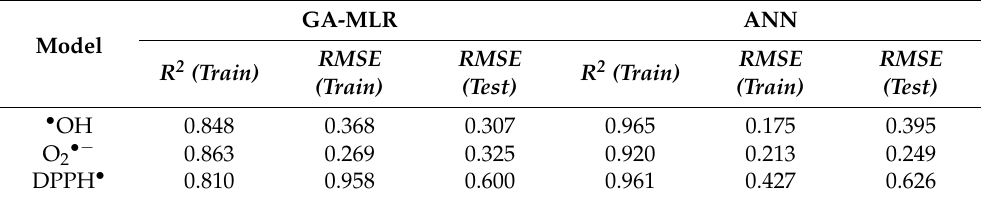
Table 3. Comparison of QSAR model results using the GA-MLR and ANN methods. GA-MLR ANN Model RMSE R 2 (Train)